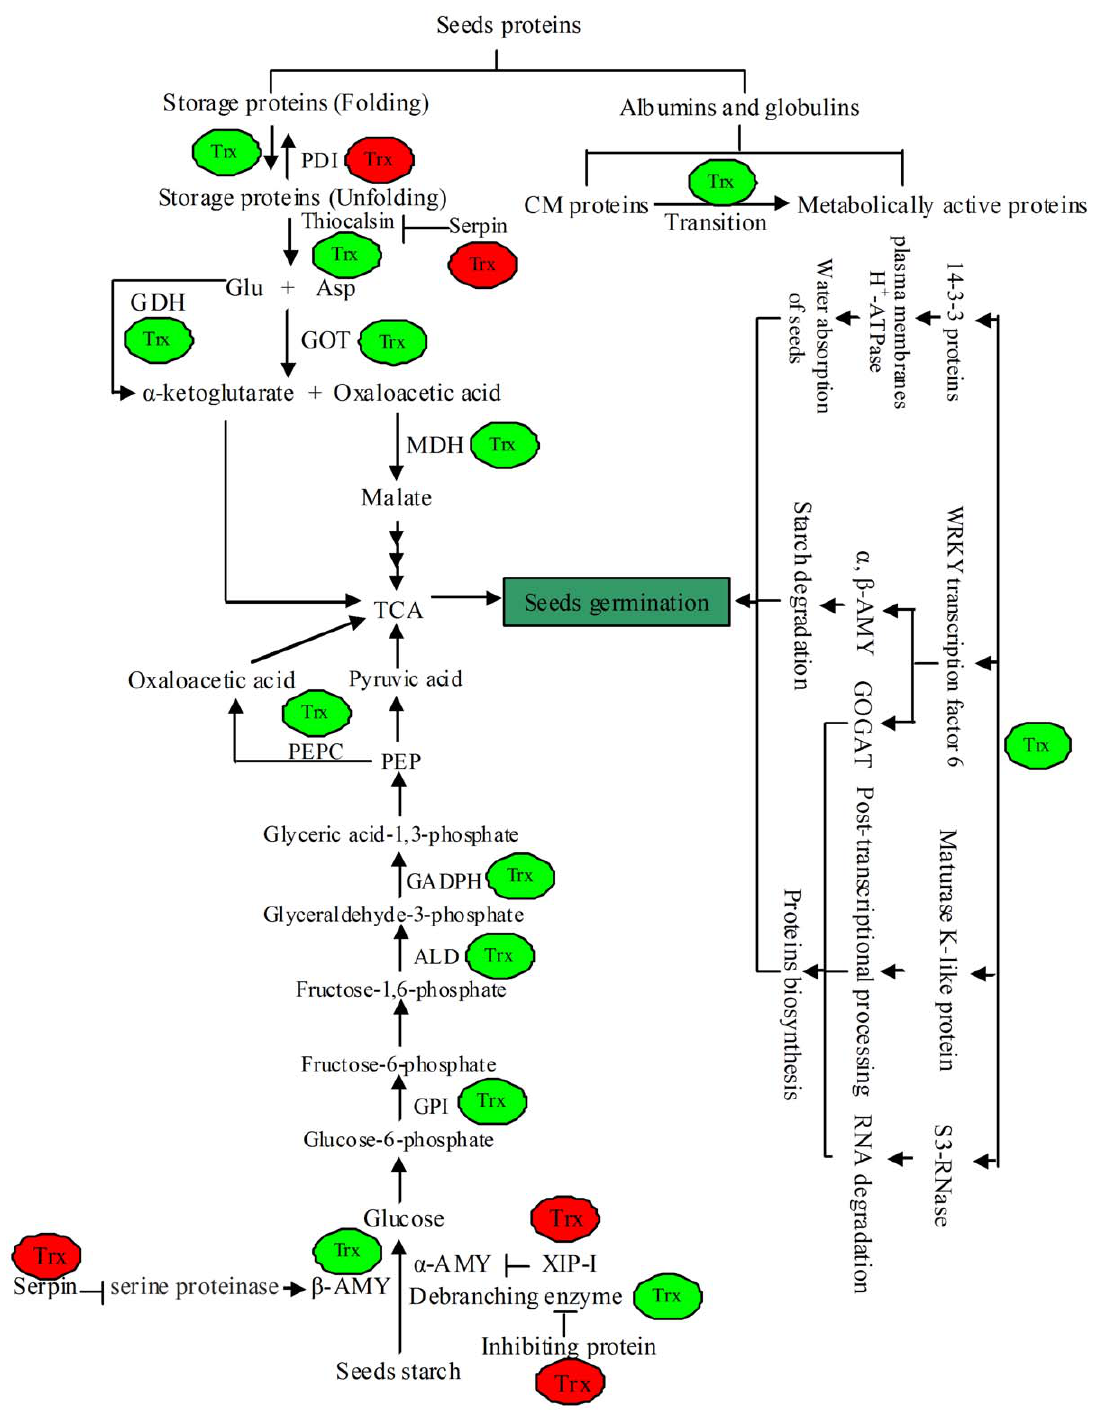
Figure 5. A proposed model for the role of Trx h in wheat seeds germination. Abbreviations are as follows: a -AMY a -amlyase, b -AMY b - amlyase, XIP-I Xylanase inhibitor protein I, GDH glutamate dehydrogenase, GOT aspartate aminotransferase, MDH Malate dehydrogenase, GPI glucose-6-phosphate isomerase, CM proteins chloroform-mwthanol proteins, PEPC phosphoenolpyuvate carboxylase, GAPDH Glyceraldehyde-3- phosphate dehydrogenase, PDI protein disulfide isomerase, ALD aldolase, GOGAT glutamic-oxalacetic transaminease. The green and red respectively mean increasing or decreasing the activity or expression of the targets.